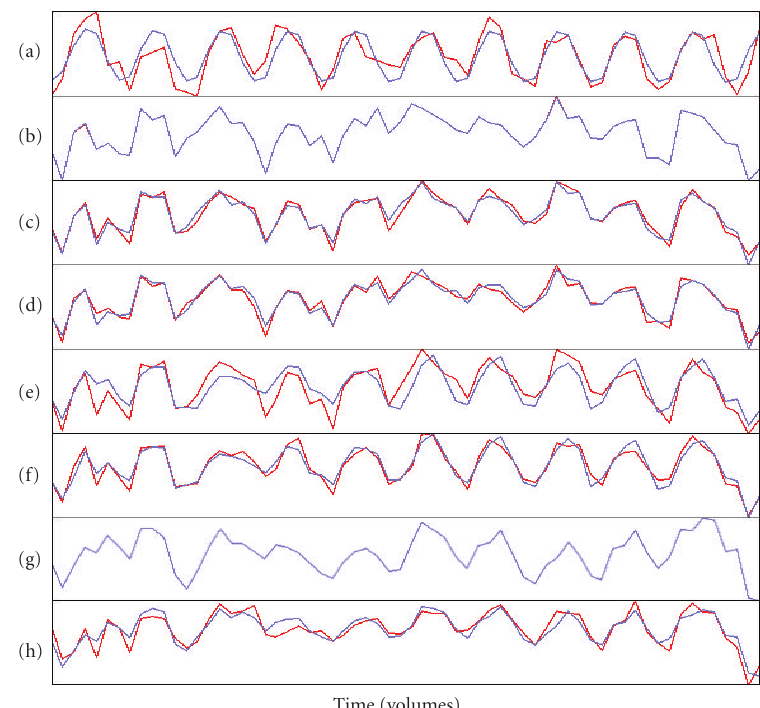
Figure 12: Time courses derived from Subject 8’s fMRI data using (a) task-related GLM; (b) single-voxel hybrid method (SV); (c) few-voxel hybrid method (FV); (d) many-voxel hybrid method (MV); (e) dual regression, single IC hybrid method (DRS); (f) dual regression, all IC hybrid method (DRA); (g) back-reconstruction with Infomax (BR-I); and (h) dual regression, single IC hybrid method, Infomax group IC seed source